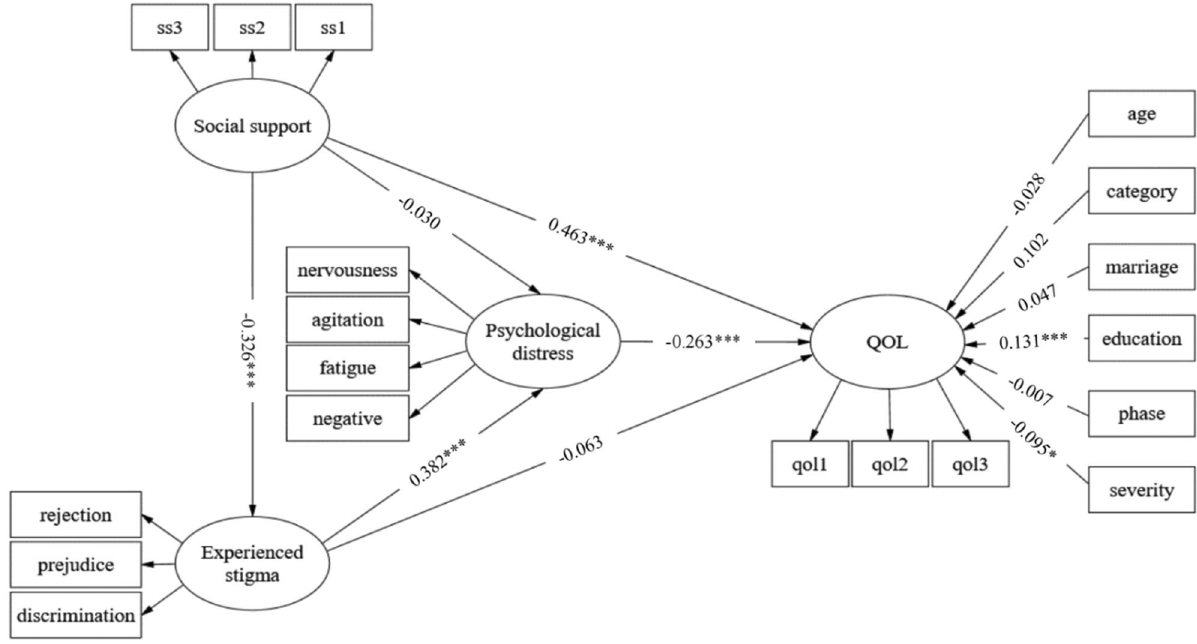
Figure 2. Pathway analysis of the relationships among social support, experienced stigma, psychological distress, and QOL. All the coefficients have been unstandardized in the figure. Three items of the Oslo social support scale are labelled ss1, ss2, and ss3. Three categories of the QOL scale are labelled qol1, qol2, and qol3. Age, treatment category, marriage status, education level, treatment phase and self-assessed severity acted as covariates. *** P < 0.001, * P < 0.05. QOL quality of life, negative negative affect, category treatment category, marriage marriage status, education education level, phase treatment phase, severity self-assessed severity. Fit of the model: Chi-square test of the model fit = 395.162; degrees of freedom = 125; GFI = 0.914; CFI = 0.939; TLI = 0.916; SRMR = 0.072; RMSEA =